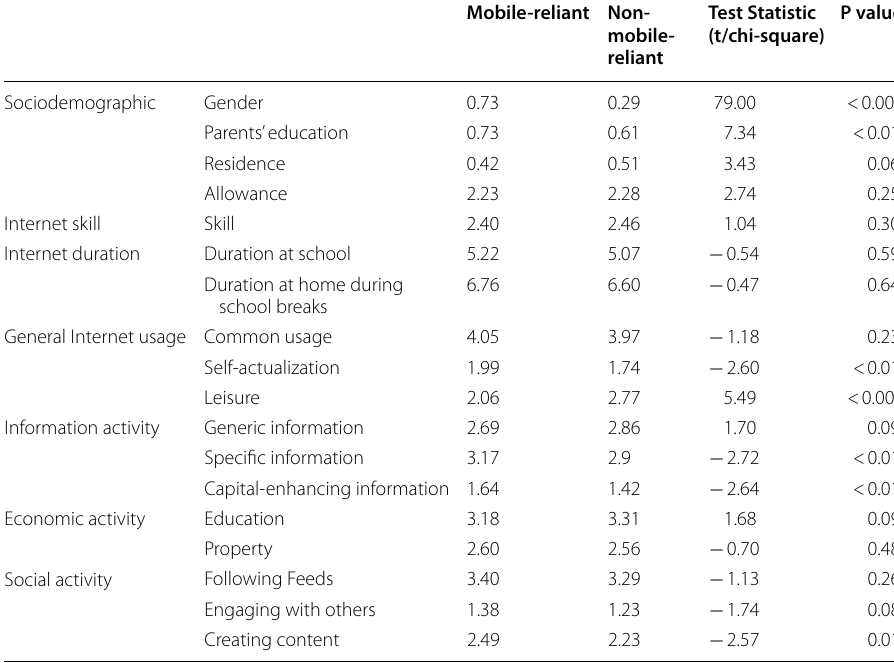
Table 3 Differences in means of key variables by device access